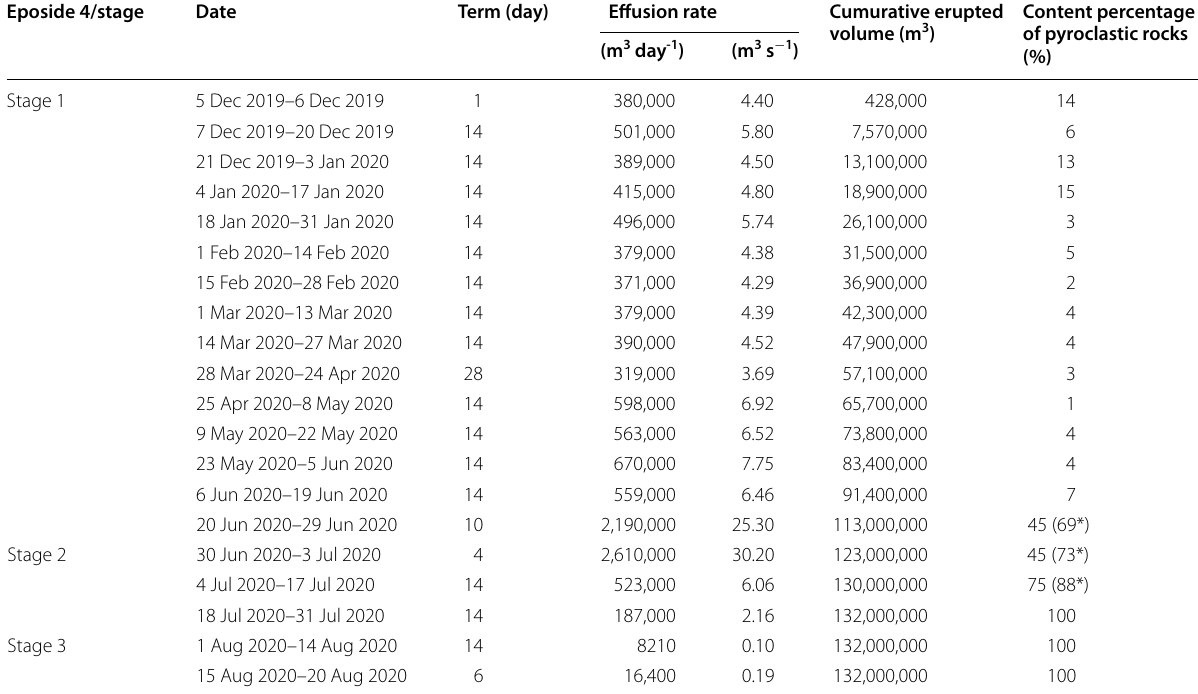
The values with asterisks in parentheses in the last column show the results when 50% of the Stage 2 lava is assumed to be derived from the lava-fountain